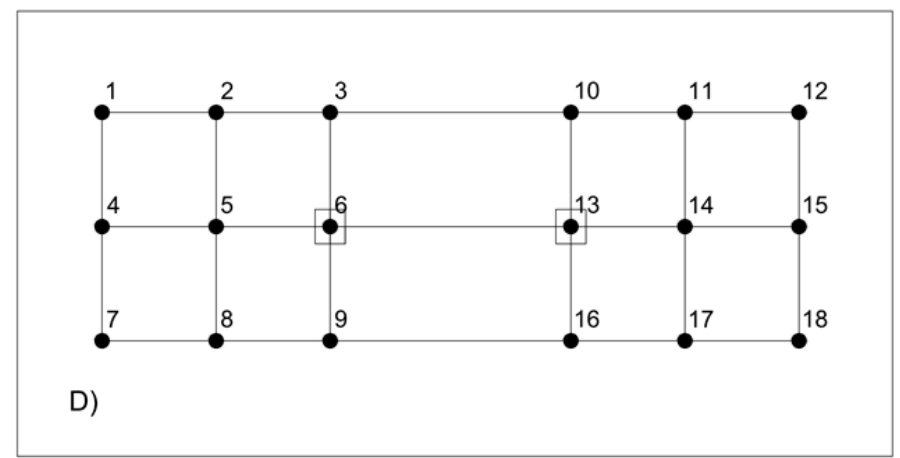
Figure 4. Two most important nodes, computed by the eigenvector centrality, for the layout D of Example Network.